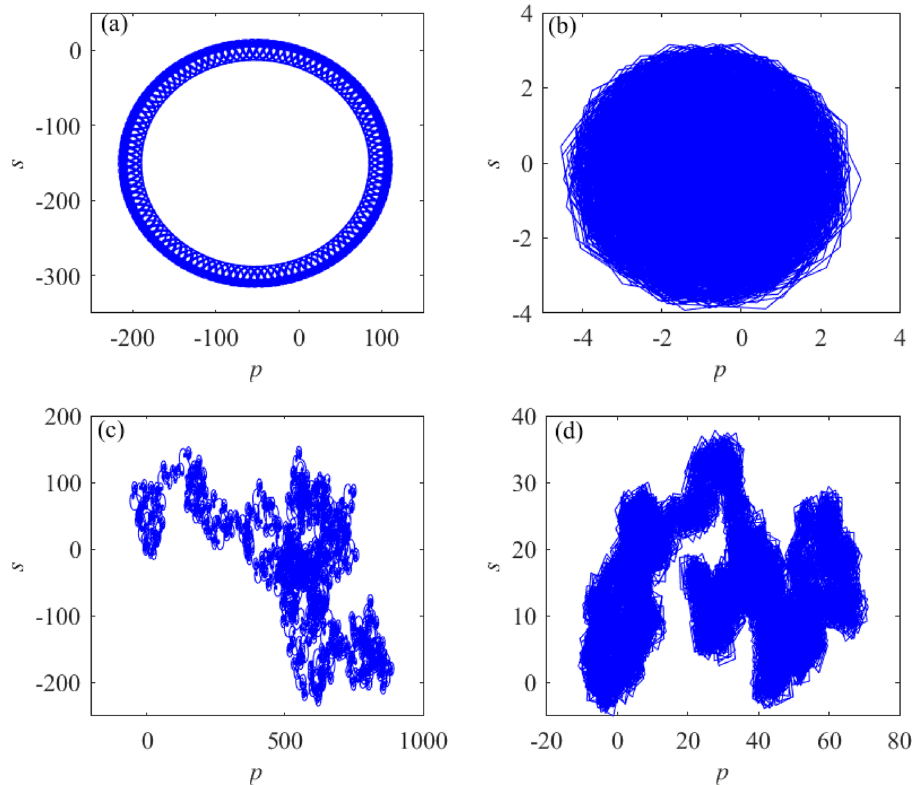
Figure 9. State space diagrams of systems (11) and (12). ( a ) The state space diagram of system (11) when a =3. ( b ) The state space diagram of system (12) when a =3. ( c ) The state space diagram of system (11) when a =6.25. ( d ) State space diagram of system (12) at a =6.25.